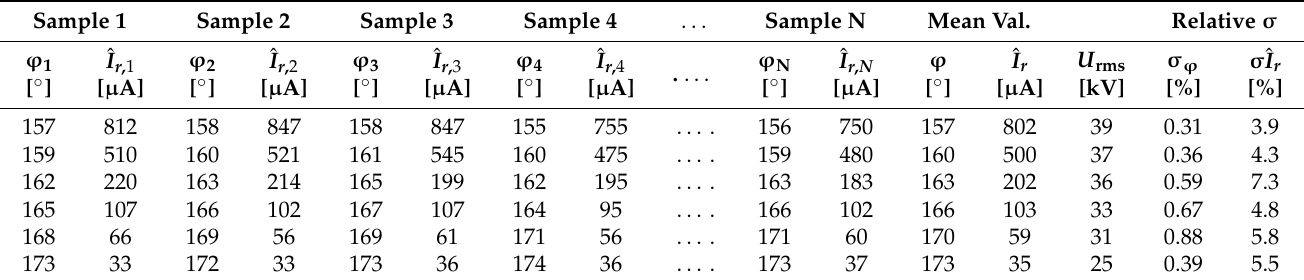
Figure 3. Measured current ( I t ) and voltage ( U ) with oscilloscope (CSV files) I t : i arrester leakage current; ii measured arrester voltage ( U ): ( a ) at U = 25 kV rms , ϕ = 173.0 ◦ , ˆ I r = 61 µ A; ( b ) at U = 27 V rms , ϕ = 172.0 ◦ , ˆ I r = 61 µ A; ( c ) at U = 31 kV rms , ϕ = 166.8 ◦ , ˆ I r = 107 µ A; ( d ) at U = 36 kV rms , ϕ = 164.2 ◦ , ˆ I r = 199 µ A; ( e ) at U = 37 kV rms , ϕ = 160.7 ◦ , ˆ I r = 545 µ A; ( f ) at U = 39 kV rms , ϕ = 158.2 ◦ , ˆ I r = 847 µ A. Table 2. Resume of measured phase delay ϕ and resistive component ˆ I r extracted from the oscilloscope. Sample